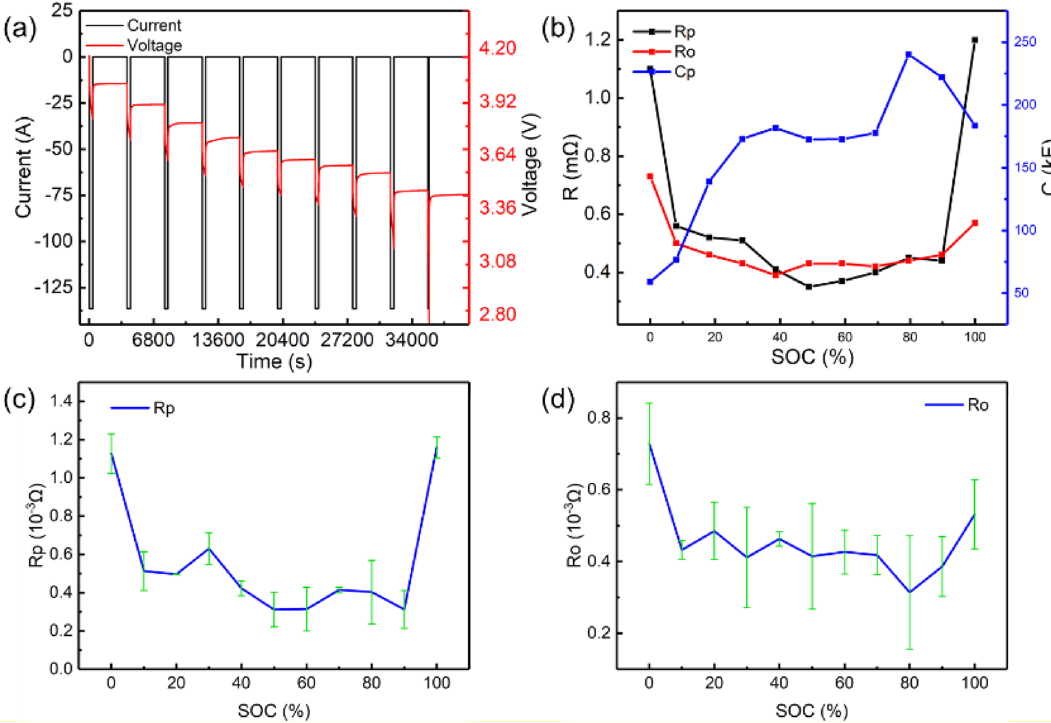
Figure 3. The experiment and results of offline parameter identification based on SA-PSO: (a) experimental measurement; (b) the result of parameter identification; (c) the error bar of identified Rp; (d) the error bar of identified Ro.